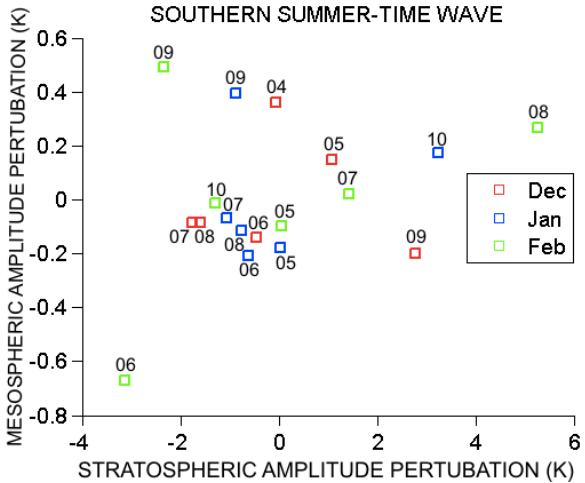
Fig. 8. Northern summer-time wave amplitudes for the winter stratosphere and summer mesosphere.